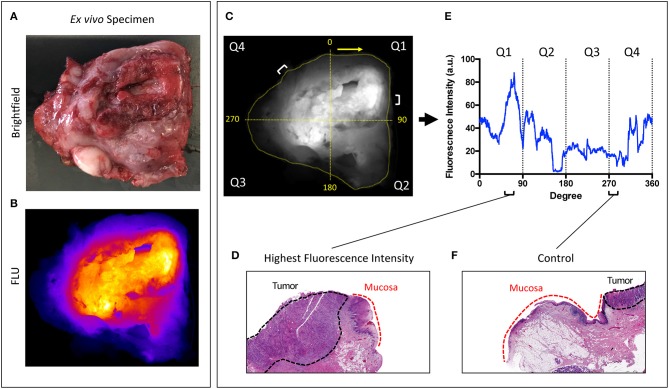
Overview of workflow. Representative brightfield (A) and closed-field fluorescence image (B) of a resected specimen. (C) Fluorescent image with mask applied circumferentially around tumor margin. Specimen divided into 4 quadrants labeled Q1−4 clockwise from 0 degrees. (D,F) H&E slides taken from regions of highest fluorescence intensity and control region of low fluorescence intensity with tumor and normal mucosa delineated. (E) Graph illustrating corresponding fluorescence intensities to peak and control at location on circumferential mask.